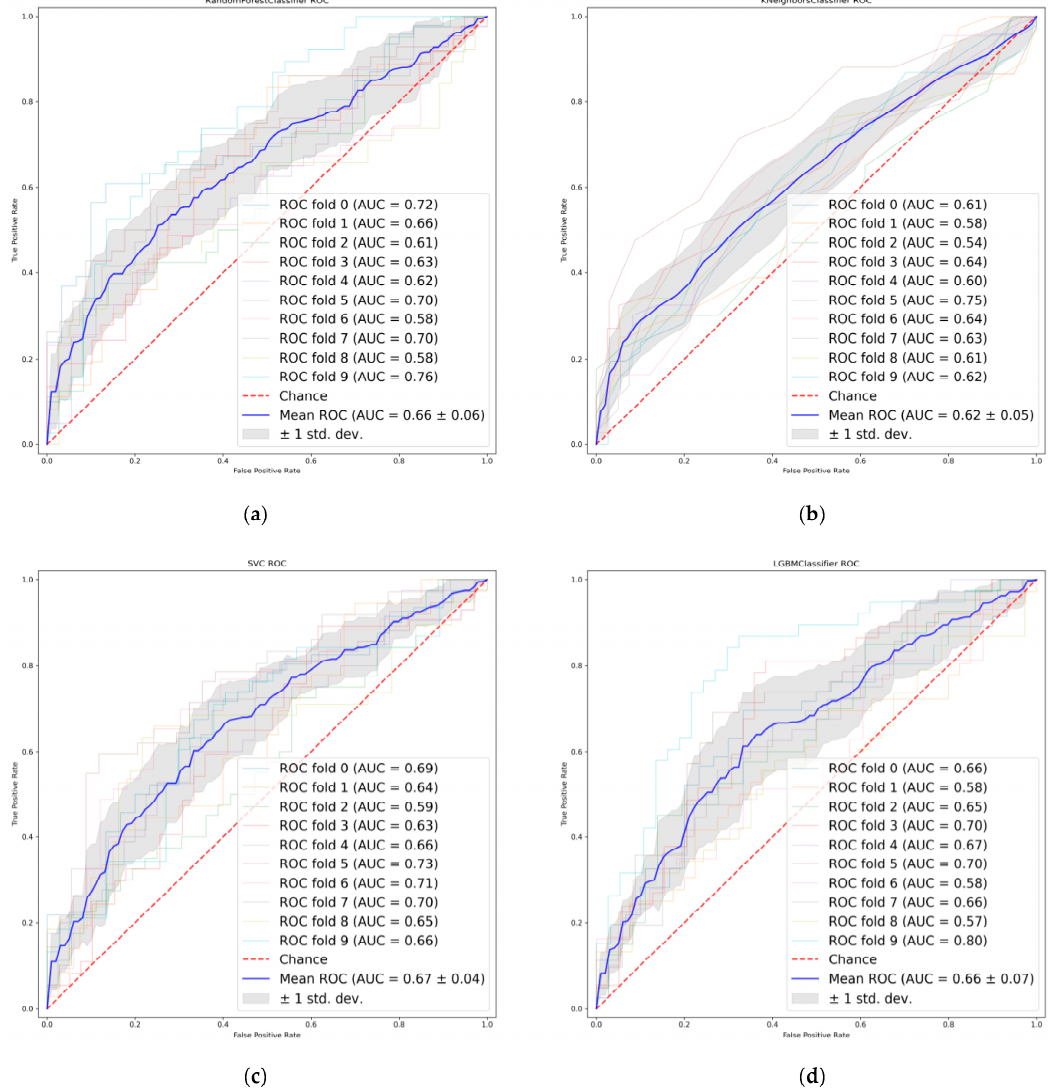
Figure 3. Receiver operating characteristics (ROC) curves of LASSO features. ( a ) Random Forest. ( b ) K ‐ nearest neighbor. ( c ) Support vector machine. ( d ) Light Gradient boosting.